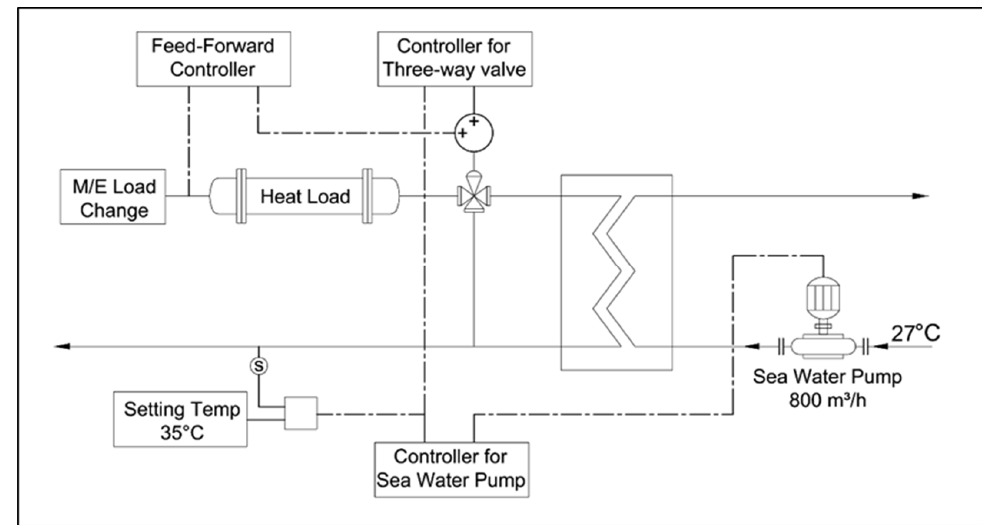
Figure 10. Central cooling system with feed-forward controller.